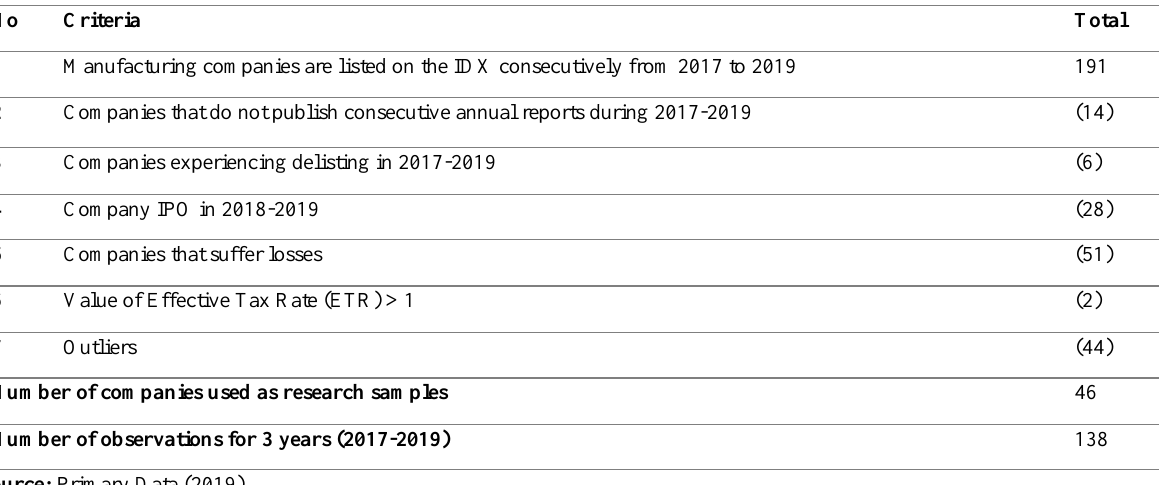
Table 1: Sample Selection